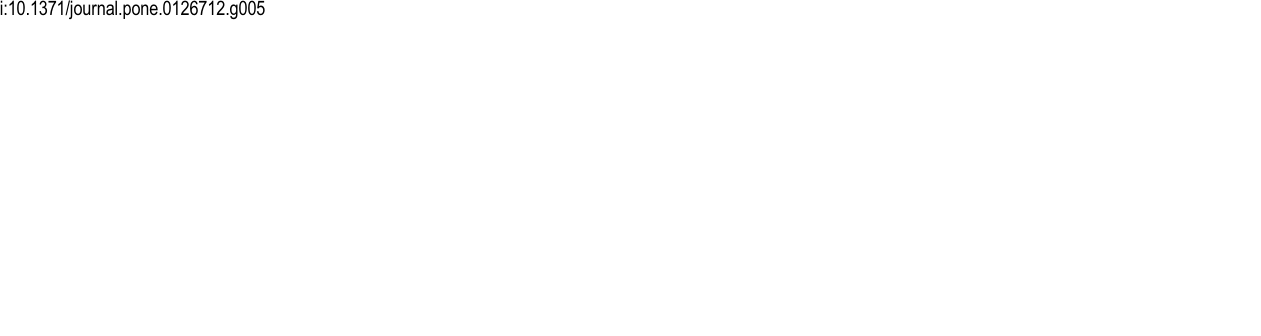
PLOS ONE | DOI:10.1371/journal.pone.0126712 May 13,